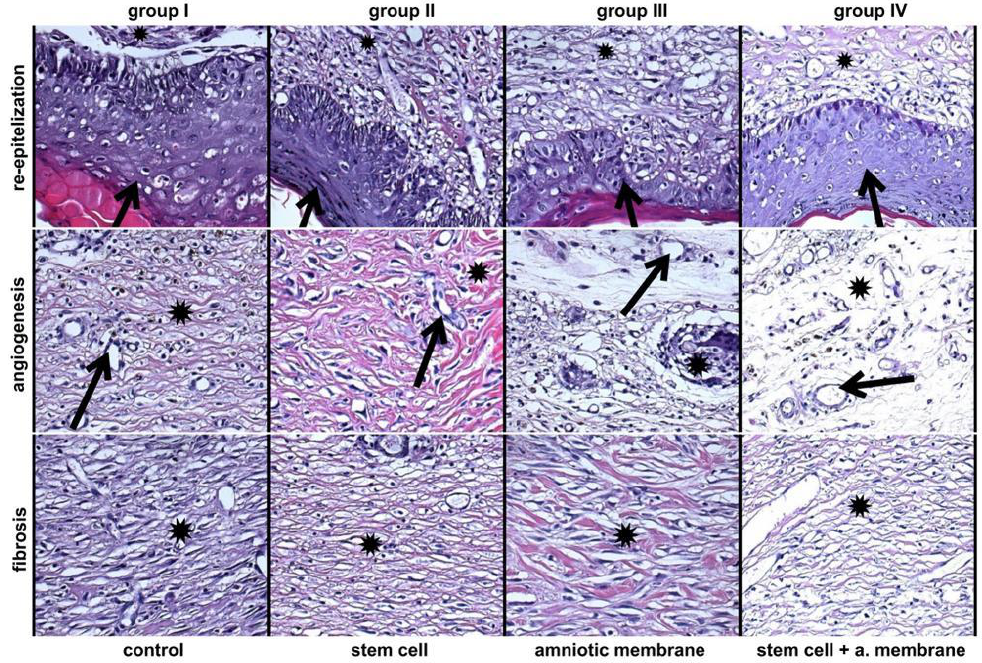
Figure 4. Depicts the signs of re-epithelialization, angiogenesis, and fibrosis with remodeling in four different groups: control (I), stem cell (II), amniotic membrane (III), and stem cell + amniotic membrane (IV). The samples were taken from the center of the lesion and analyzed using HE staining (hematoxylin-eosin) at 200× magnification. All groups, from I to IV, exhibit indications of complete re-epithelialization, as evidenced by a well-formed epidermis (indicated by a black arrow) over mature fibrous tissue (indicated by an asterisk). Angiogenesis is represented by numerous newly formed vessels (indicated by a black arrow) amidst fibrous stroma (indicated by an asterisk). Additionally, fibrosis with remodeling is represented by dense connective tissue containing thick, pink fibers that penetrate newly formed vessels (indicated by an asterisk). 3.3. Comparison of Interleukin Protein 1 (IL1) Concentration in Tissues Adjacent to the Skin Wound in Rats To investigate the comparison of interleukin protein 1 (IL1) concentration in tissues adjacent to the skin wound compared to that in the normal controls. IL-1 expression revealed a lower expression in groups BMSCs and BMSCs + AM (3.615 ± 1.28 and 2.817 ± 0.82; p = 0.960). No significant variation in IL-1 was observed in the BMSCs and AM group only (Figure 5). Figure 5. Effect of AM and BMSCs on Interleukin marker IL-1. Results are expressed as mean [interquartile range] ± SEM (N = 10). p < 0.05 denoted statistical significance in comparison to the Control